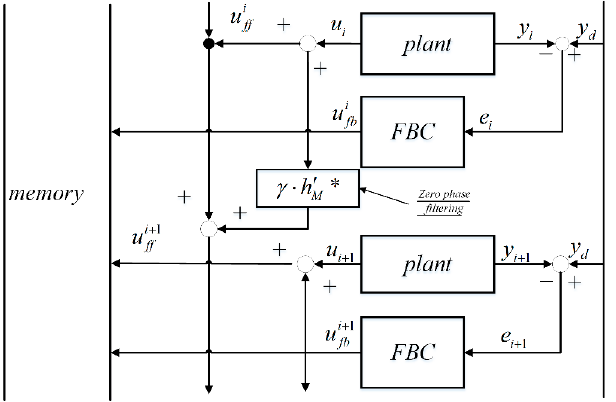
Figure 18. Block diagram of zero-phase filter-based iterative learning control. Reprinted with permission from ref. [104]. Copyright 2001 IEEE.